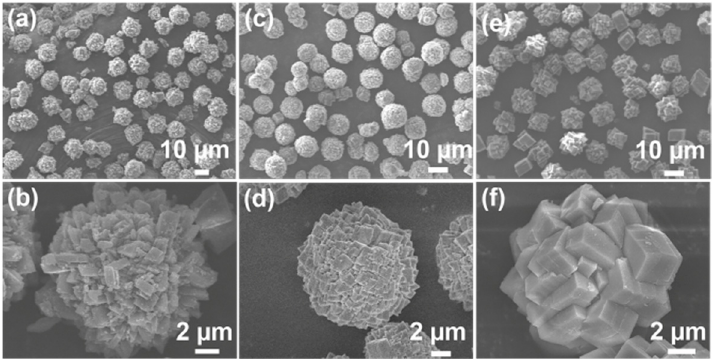
Figure 2. Scanning electron microscope (SEM) images of the samples synthesized at different crystallization temperatures (( a , b ) for S1 (150 °C), ( c , d ) for S1 (180 °C), and ( e , f ) for S1 (200 °C)).